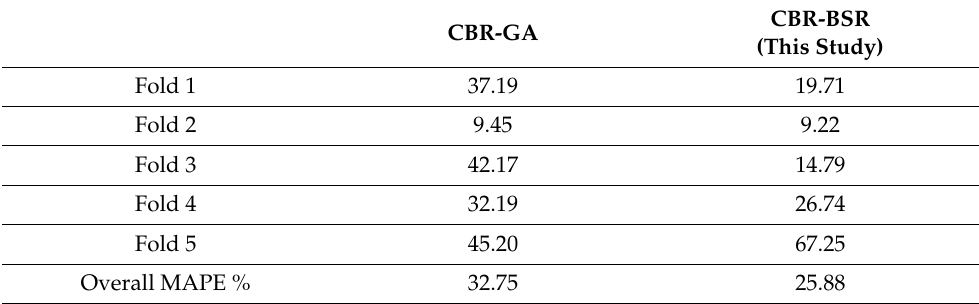
Table 2. MAPE % Performances of Data set